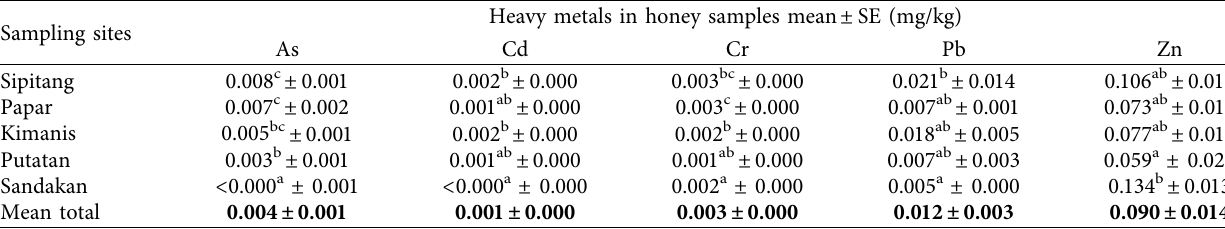
Table 2: Mean concentrations of heavy metals in honey (SE) from five sites. Heavy metals in honey samples mean ± SE Sampling sites